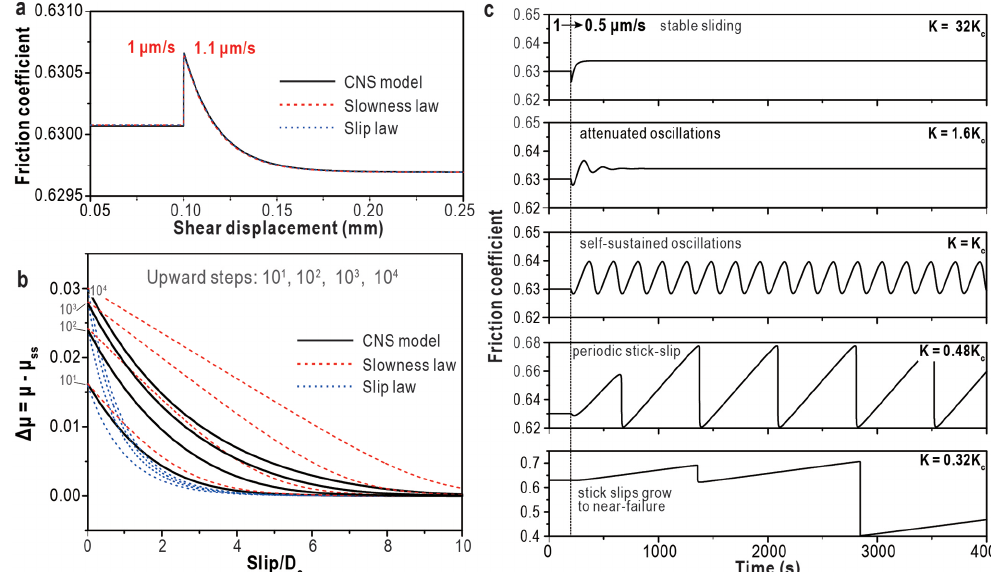
Figure 8. Comparison between CNS- and RSF-based models. (a) Small (1 → 1 . 1µms − 1 ) and large (up to 4 orders of magnitude) perturba- tions in sliding velocity (the upper and lower diagrams, respectively). The RSF parameter values used are the equivalent values calculated from the CNS model (see Chen et al., 2017). (b) CNS modelling of a velocity step 1 → 0 . 5µms − 1 for different stiffnesses K (see Chen and Niemeijer,